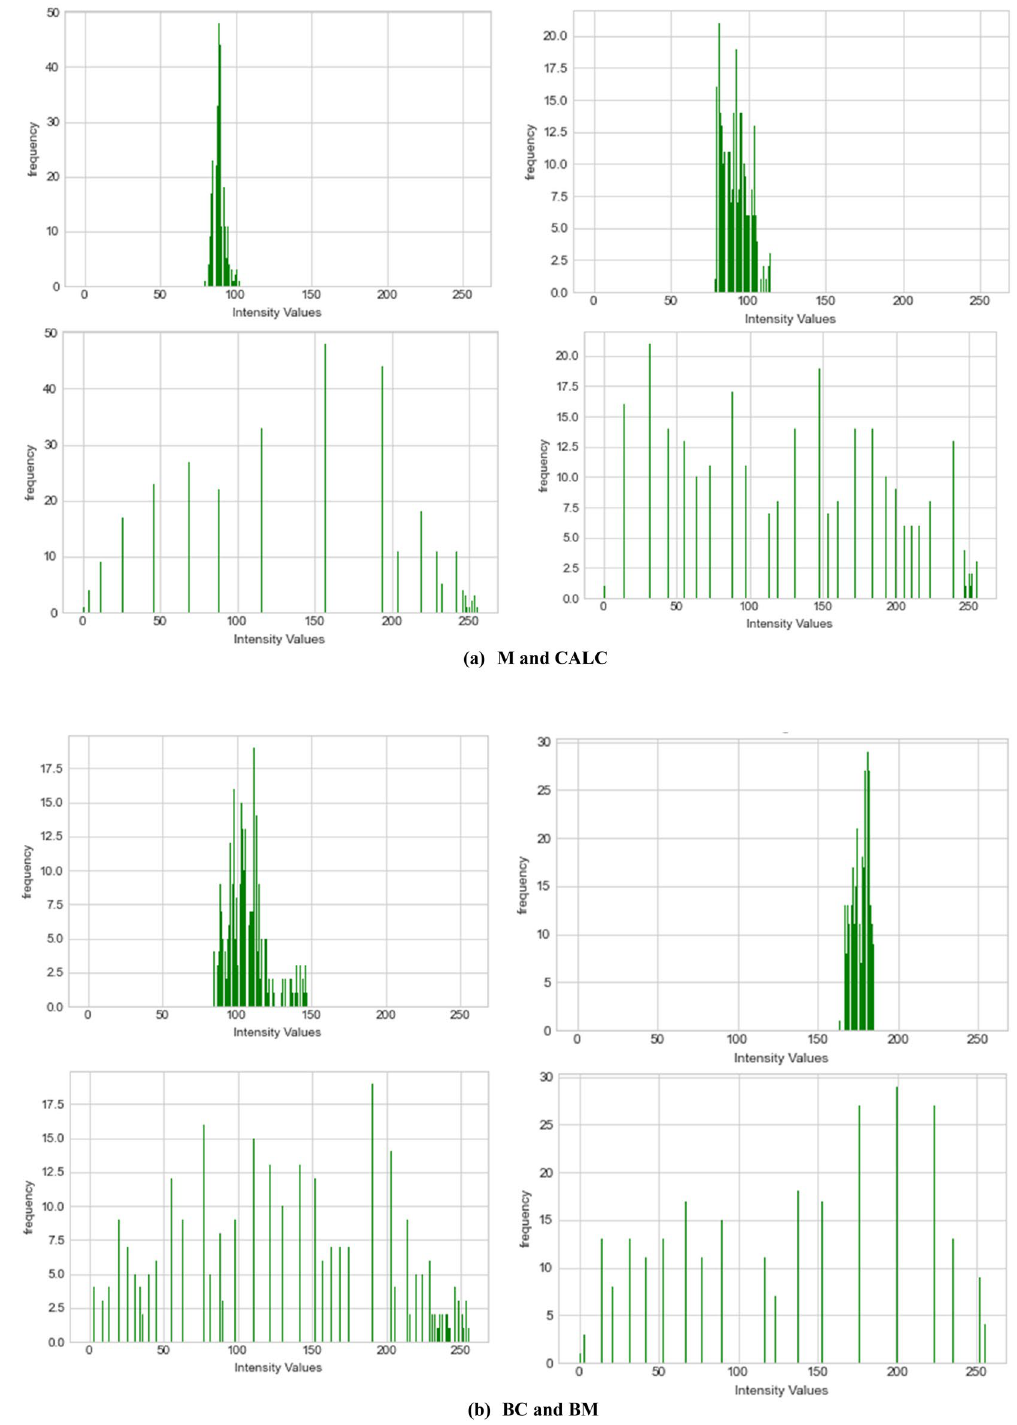
Figure 9. Computation and graphing of the histogram with the corresponding equalized histogram for the image samples used for the experimentation preprocessed using CLAHE. ( a ) M and CALC abnormalities and ( b ) shows BC and BM